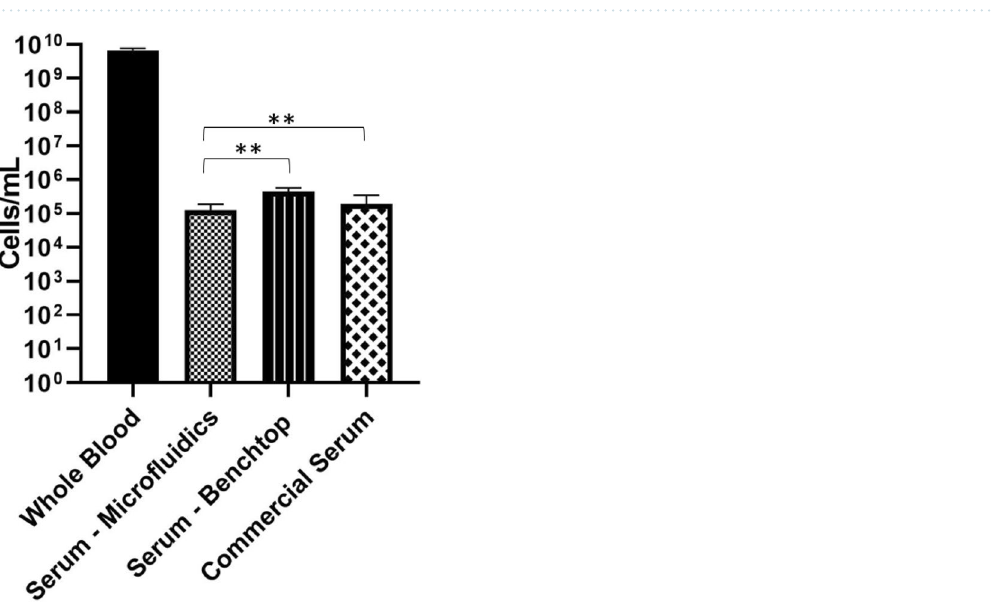
Figure 3. Schematics of one-step ( A ) vs. two-step ( B ) cross-flow filtration, with corresponding photos of phase separations on the microfluidic device; ( A ) the one-step filtration method was ineffective at separating a large fraction of blood cells from serum; ( B ) the two-step filtration method was successful at separating serum from blood.